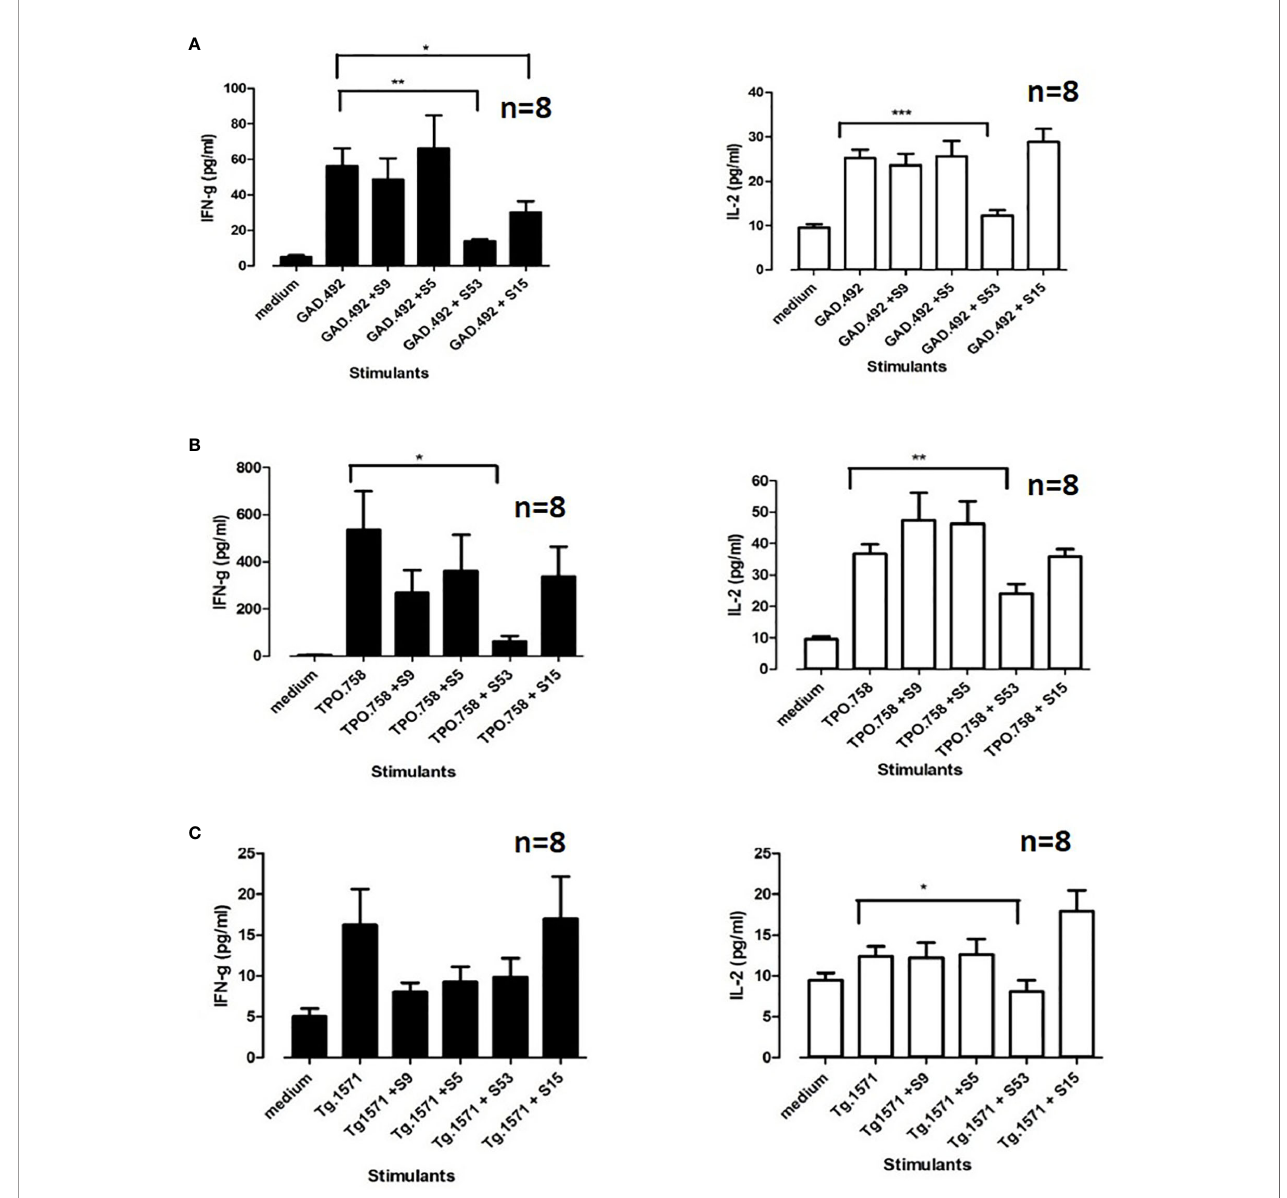
FIGURE 8 | Eight humanized NOD-DR3 mice were co-immunized with Tg.1571, GAD.492 and TPO.758. Splenocytes were co-incubated with peptides and small molecules ex vivo . Stimulated splenocytes were collected and assayed for cytokine production. Figure 8 shows interferon gamma and IL-2 production when GAD.492 (A) , TPO.758 (B) and Tg.1571 (C) were co-incubated with the top four small molecules (S9, S5, S53 and S15) in splenocytes of the immunized mice. *p < 0.05; **p < 0.01; ***p <